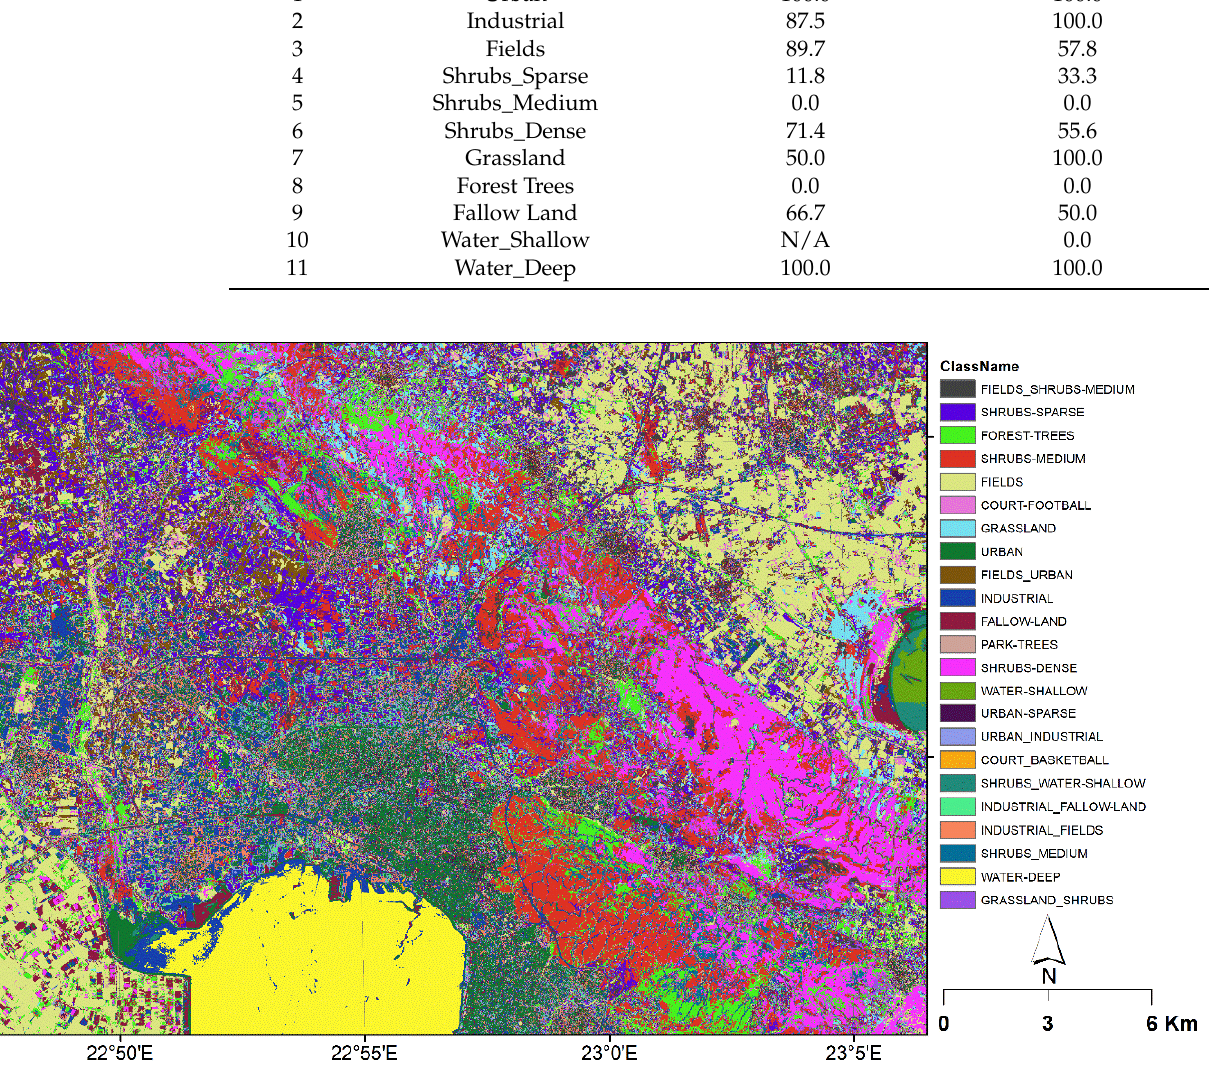
Figure 6. The classified image resulting from the 139-scale segmentation.